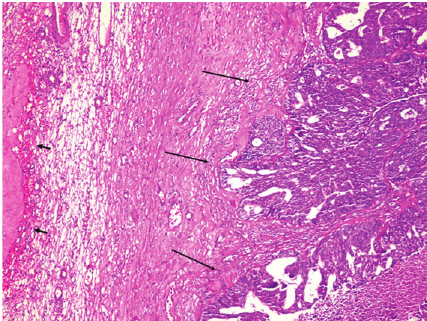
Figure 1: Ovary tissue, in the adjacent of corpus albicans (short arrows), showing irregular neoplastic glandular structure (long arrows), × 200 H & E.